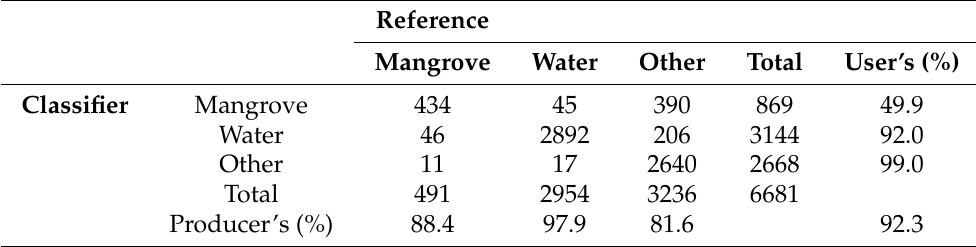
Figure 7. Mangrove extent over time for the French Guiana site. Years 1990 and 2019 were excluded from analysis because the class maps for those years contained less than 60% valid pixels. Table 6. Results of spatiotemporal accuracy assessment for North Kalimantan, Borneo